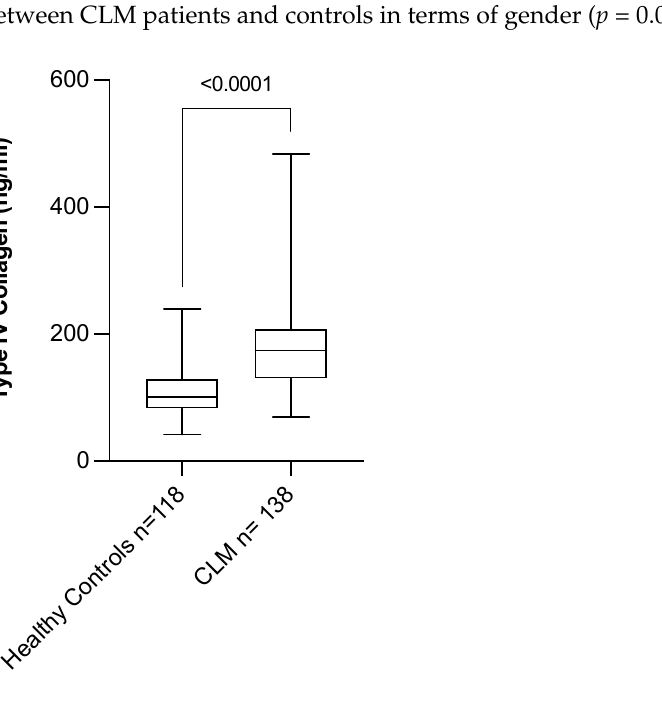
Figure 6. Levels of circulating type IV collagen (cCOL IV) in healthy controls and patients with colorectal liver metastases (CLM). Patients with CLM had significantly higher levels of cCOL IV (174.1 ng/mL (69.9–483.1)) compared with heathy controls (101.2 ng/mL (42.4–239.2)) ( p < 0.0001). Separate regression models for controls and patients showed that the level of cCOL IV in controls increased with age ( p < 0.0001), but this was not the case for CLM patients ( p = 0.1295). Gender did not affect the level of cCOL IV for either controls ( p = 0.8109) or patients ( p = 0.6072). Multiple linear regression analysis of age and case-control status in patients and controls combined showed that age ( p = 0.0011) and case-control ( p < 0.0001) significantly affected cCOL IV levels. Age thus had an effect on the model, but the effect of case-control status was